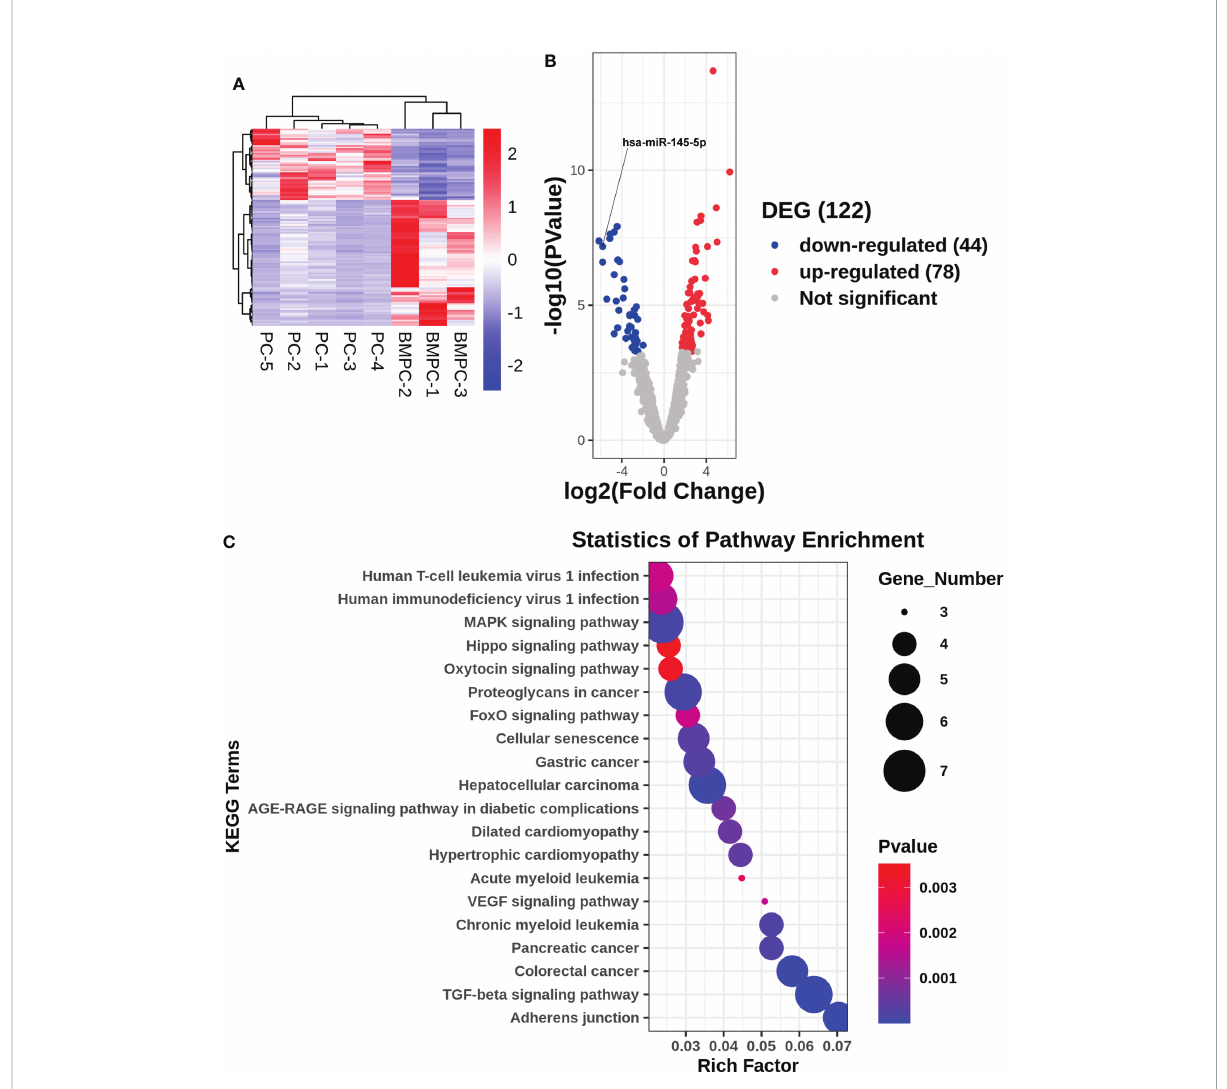
FIGURE 2 Gene expression pro fi le for non-metastatic and bone metastatic prostate cancer. (A, B) Heat map and volcano plot showing miRNA expression levels. Right column: genes; red pixels: upregulated expression; blue pixels: downregulated expression. (C) KEGG pathway miRNA analysis. X axis: enriched genes; Y axis: KEGG pathway; dot color: p-value; dot size: gene